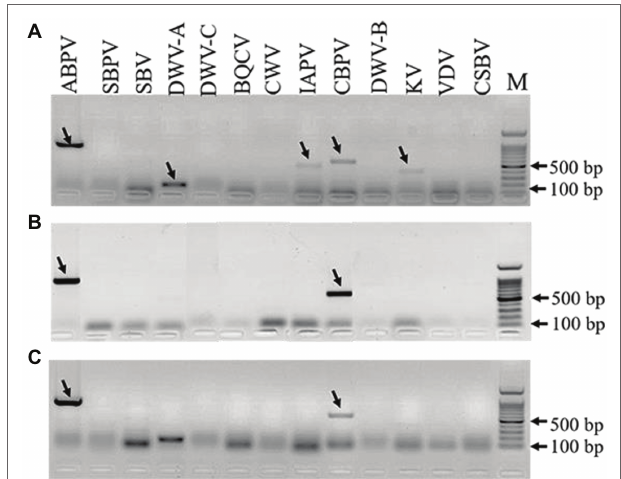
FIGURE 5 | Detection of honey bee viruses in Aspergillus tubingensis and Aspergillus apis . Viruses detection in A. tubingensis HYS (A) . Virus detection in A. apis HQS-1 and HQS-2, respectively (B,C) . M: 100 bp DNA Marker. The arrowheads indicated the destination strips. To avoid potential recombination between Deformed wing virus (DWV) and VDV, we used another pair of primers to detect the presence of VDV.